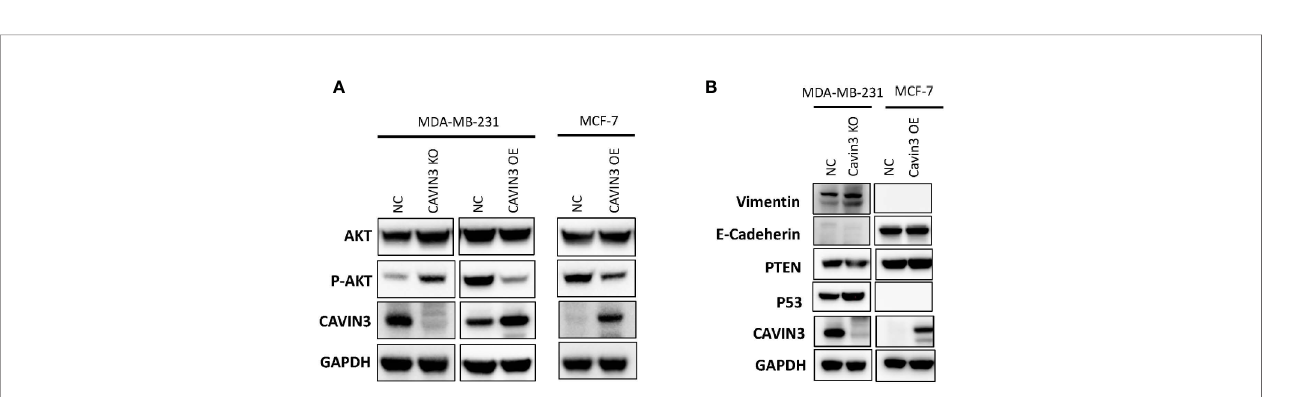
FIGURE 5 | Cavin3 suppresses breast cancer metastasis by down-regulating the AKT pathway. (A) Loss of cavin3 increases the level of p-AKT and gain of cavin3 decreases the level of p-AKT; (B) No effect of cavin3 expression on PTEN expression, and EMT markers were observed. KO, knockout; NC, normal control; OE,